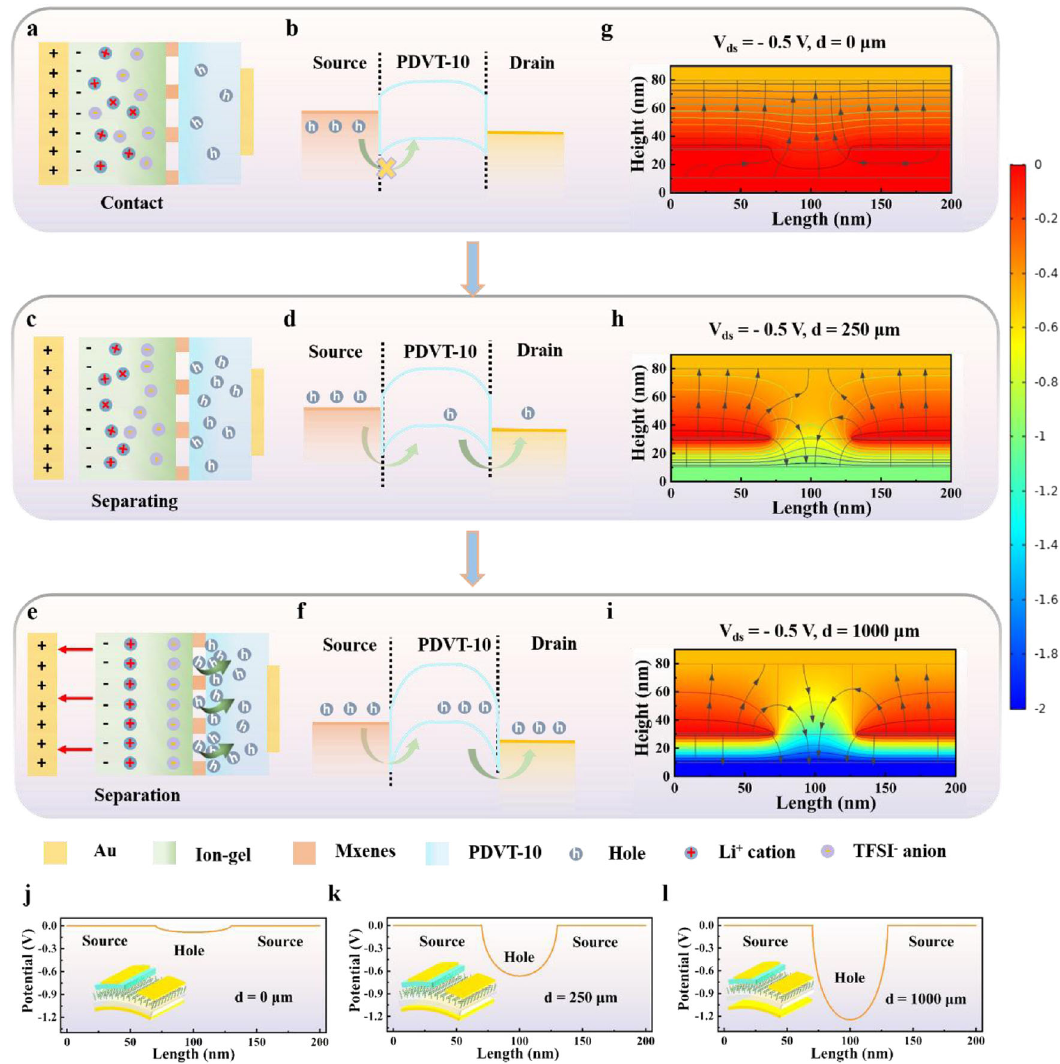
Fig.3|Theworkingmechanismofmulti-sensingVTTunit.a Chargedistribution of the source/channel/drain layers when gate is in contact with the IL layer. b Correspondingbanddiagramofeachlayeratcontactstate. c Chargedistribution of the source/channel/drain layers when gate is separated from the IL layer. d Corresponding band diagram of the source/channel/drain layers when gate is